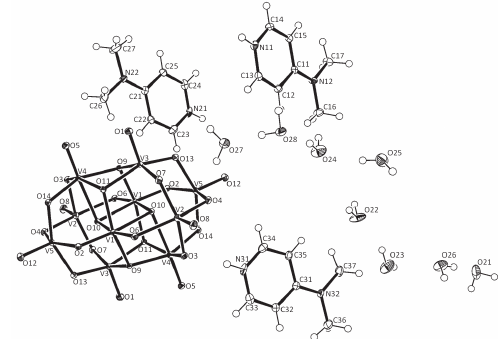
Table 2: Atomic coordinates and displacement parameters (in Å 2